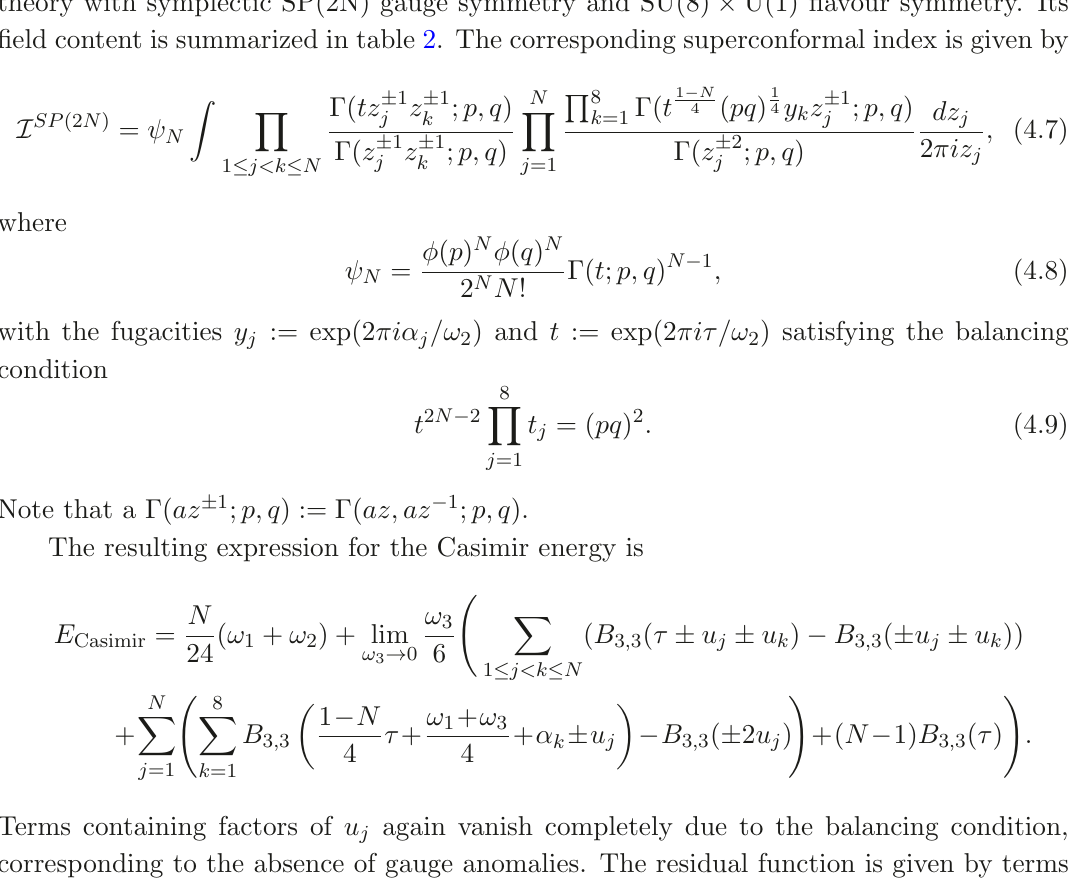
Table 2 . The matter content of the flavour symmetry. T A denotes the antisymmetric tensor